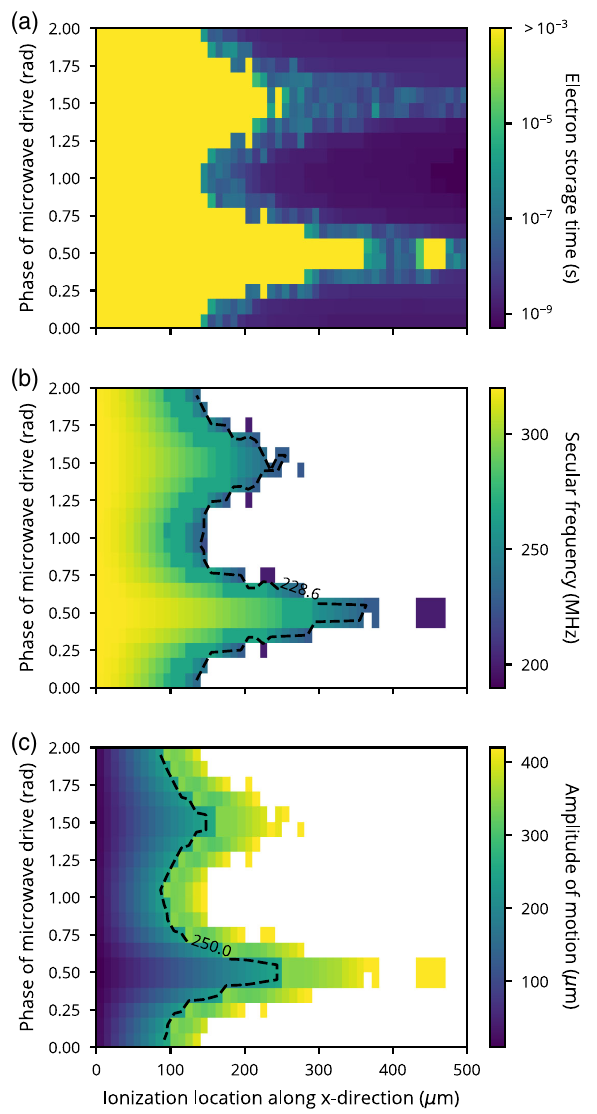
FIG. 9. Electron motion simulations. (a) Storage times for one- dimensional motion through the trap along the x axis and the trap center [see Figs. 2(a) and 2(b)]. Storage times are calculated for a maximum time of 1 ms. The plot axes indicate the ionization location and the microwave phase at the time of ionization. The electron is assumed to have zero kinetic energy at the time of ionization. (b) Secular frequency of motion. The dashed curve highlights the frequency contour for the seventh subharmonic of the microwave drive frequency. (c) Corresponding motion am- plitudes. The dashed contour line for an amplitude of 250 μ m highlights where the motion frequency coincides with the sixth subharmonic of the drive frequency and the motion amplitude increases abruptly. White areas in panels (b) and (c) indicates storage times below 1 μ